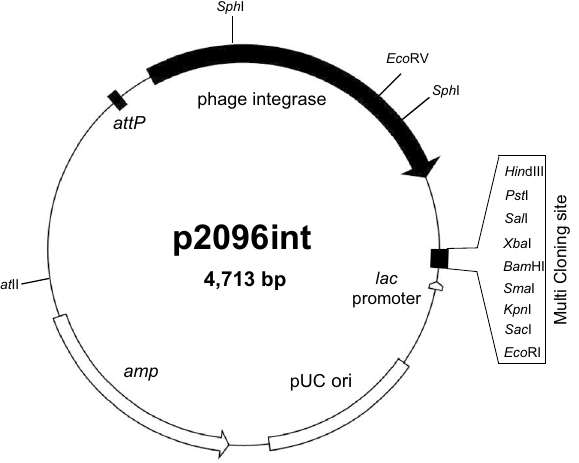
Figure 7. Plasmid map of a chromosome-integrative vector p2096int. p2096int vector contains attP , the integrase gene, multiple cloning sites (MCS), lac promoter, and an ampicillin-resistance gene. The vector is a pUC-based multicopy number plasmid propagated in E. coli , while it is a chromosome-integrative vector in the A. pasteurianus C-27 strain.